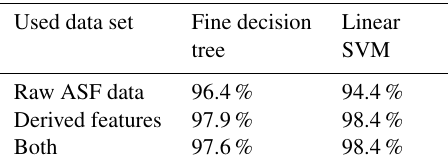
Table 1. Classification accuracies for different ML approaches and different input